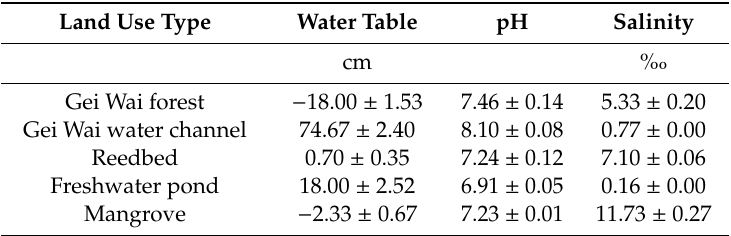
Table 1. Water table, soil pH, and soil salinity for the five land use types at the Mai Po Marshes (means ± standard deviation, n =